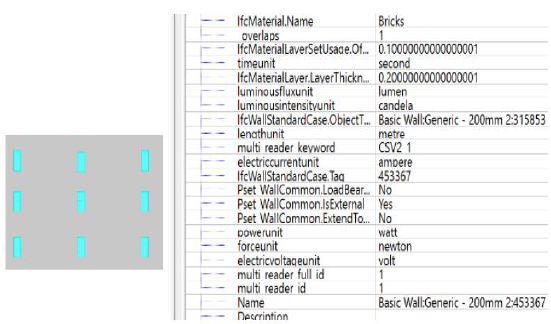
Figure 3. IFC material of walls transferred to CityGML LoD 4 model.